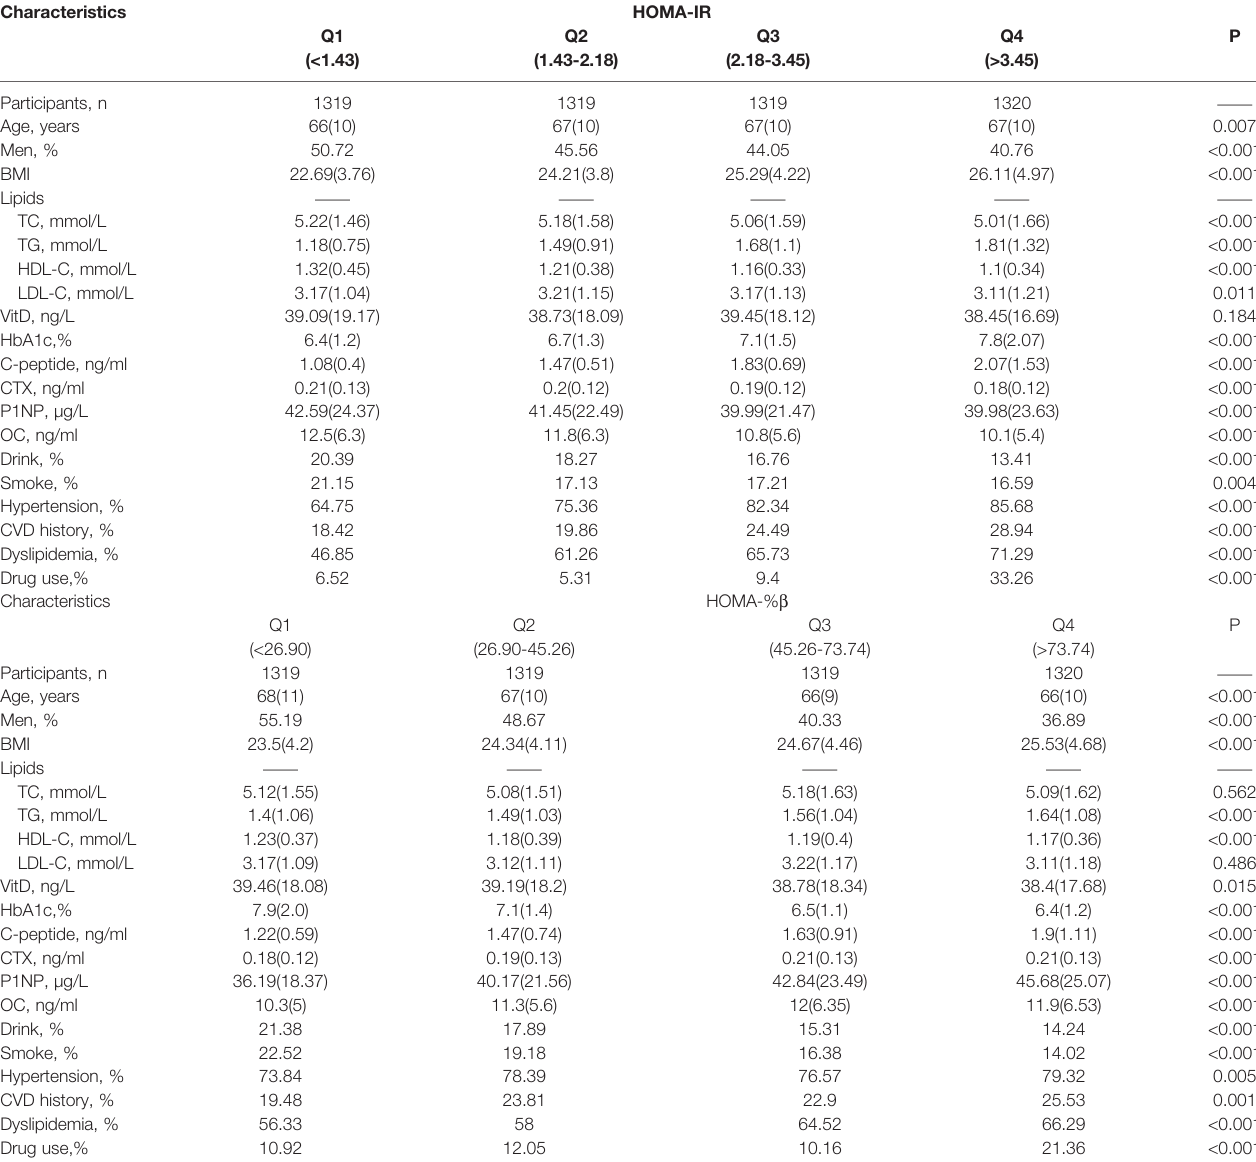
Data are expressed as the median (IQR) for continuous variables and as percentages for categorical variables. The nonparametric test and chi-square test were